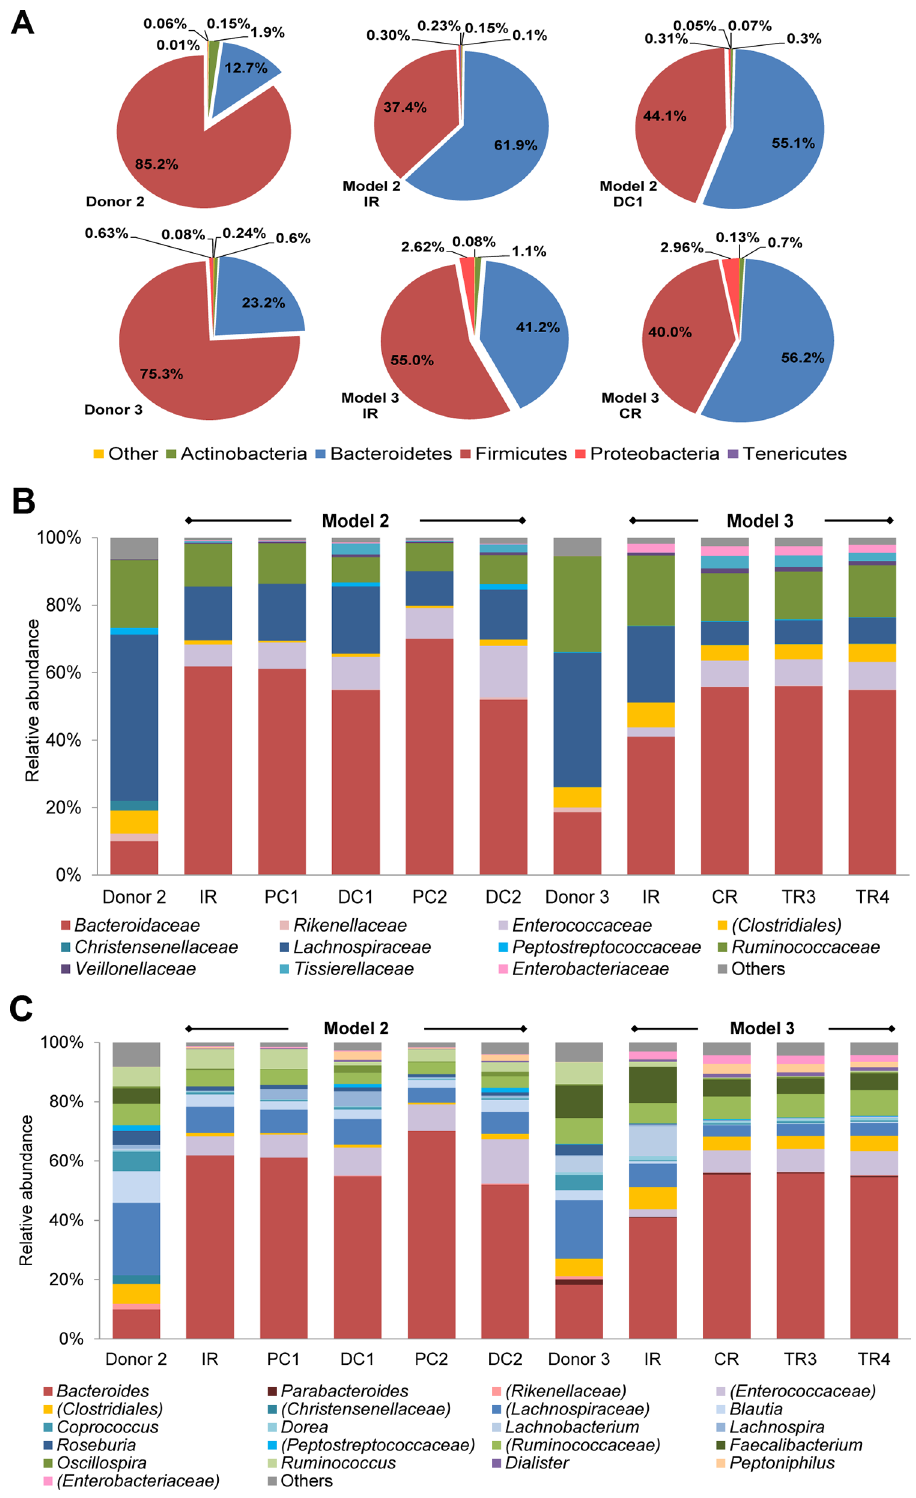
Fig 2. Microbial composition of fecal samples and reactors of PolyFermS models measured by 454 pyrosequencing. Relative abundance at (A) phylum level of fecal samples of donors 2 and 3, IR and DCI of model 2 and IR and CR of model 3 (B) family level and (C) genus level of fecal samples of donors 2 and 3, all